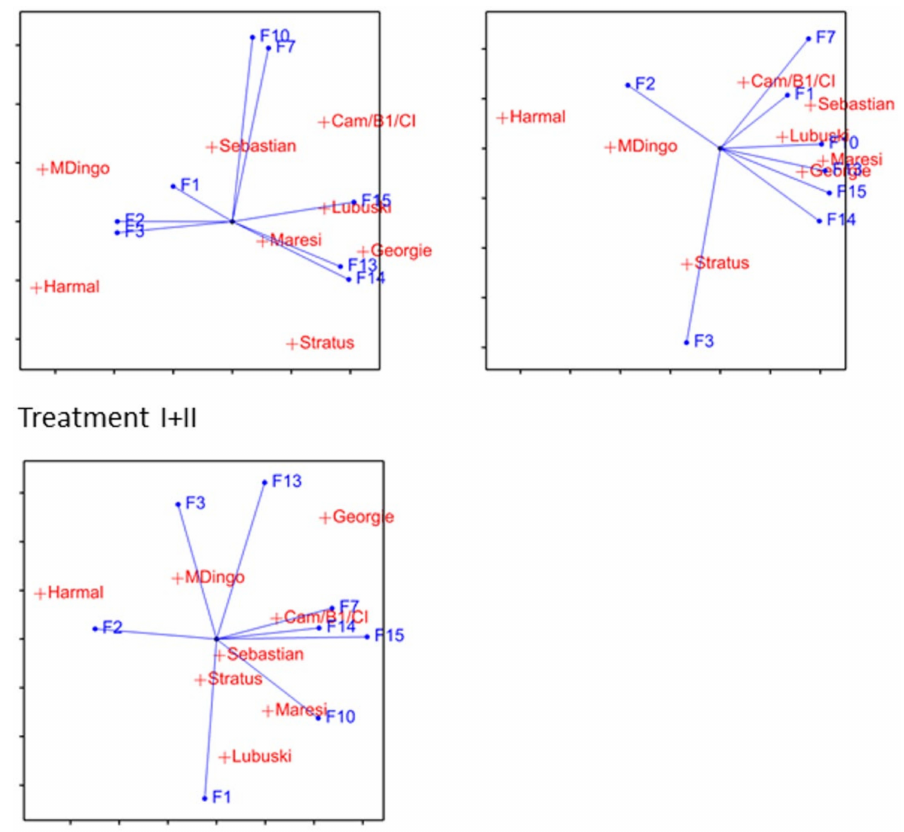
Figure 8. Biplots constructed for phenotypic traits with variety-specific water deficiency e ff ects under treatments I, II, I +